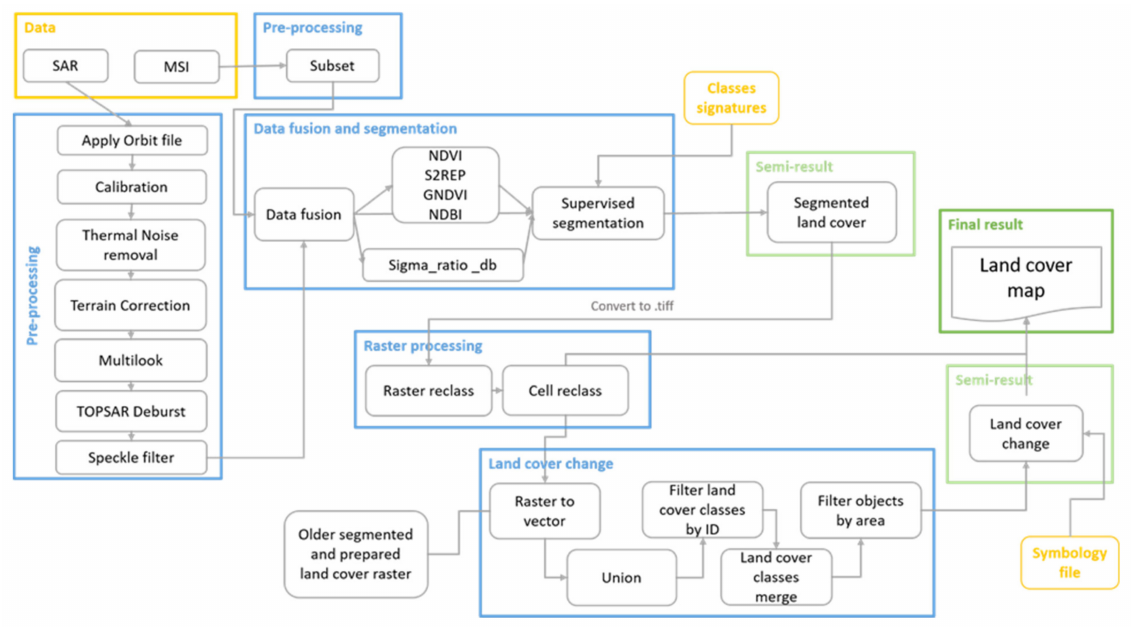
Figure 9. Methodological scheme for satellite image processing, data fusion and identification of land cover changes.